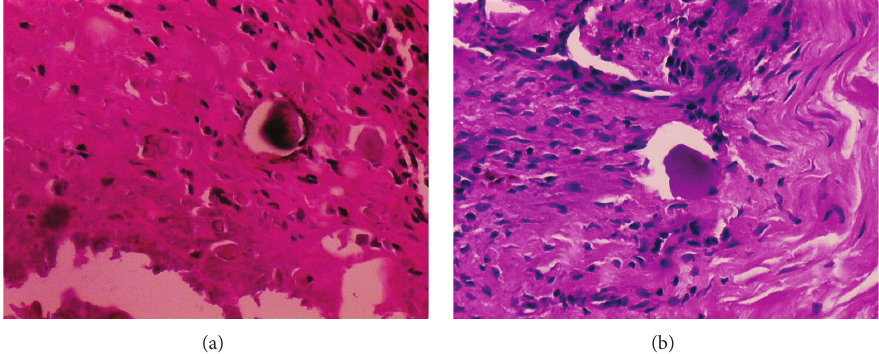
Figure 2: (a) Microscopically, there are a few neutrophils with some Actinomyces microorganisms and eosinophilic hyaline material (H&E, 200x). (b) Histochemically, the microorganisms are positive with PAS staining (PAS,